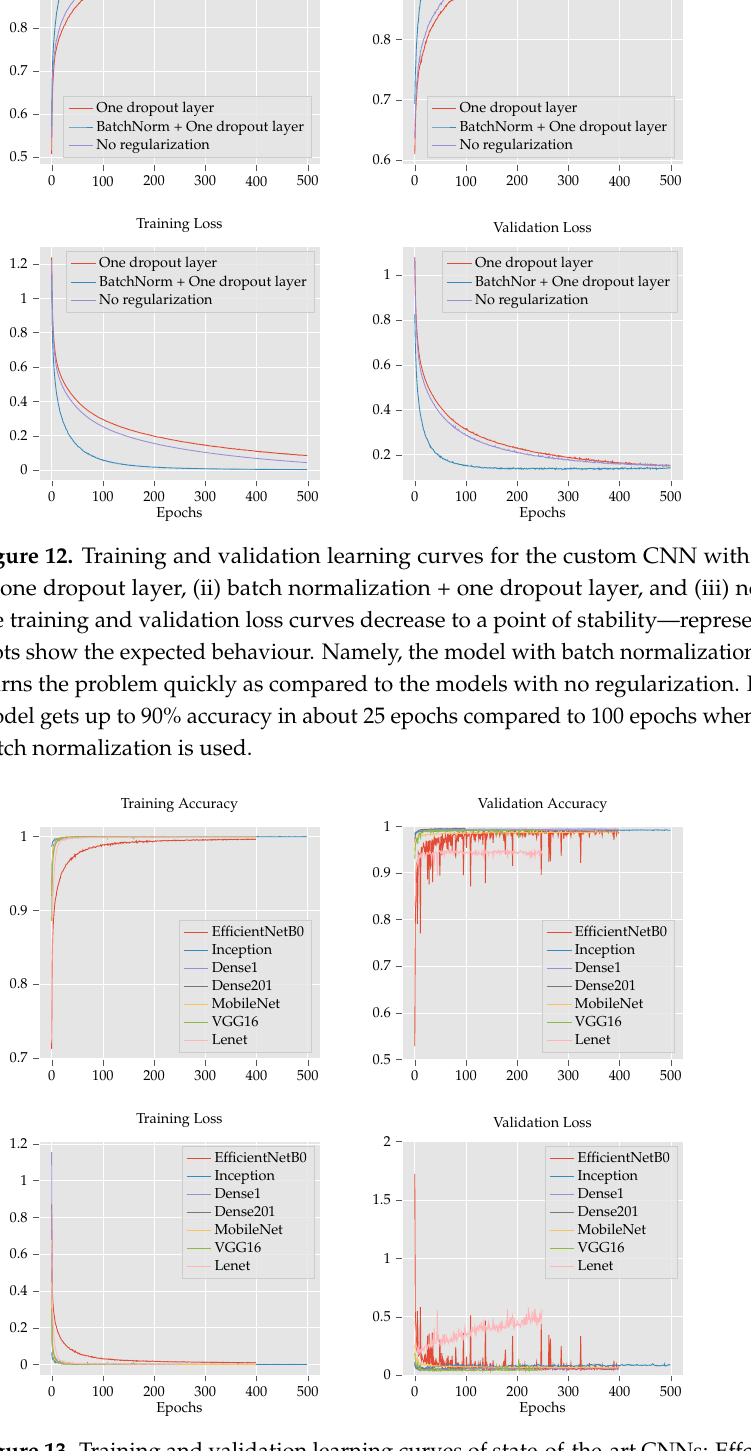
Figure 13. Training and validation learning curves of state-of-the-art CNNs: EffcientNetB0, Inception, DenseNet101, DenseNet201, MobileNet, VGG16 and Lenet. All the training and validation loss curves decrease to a point of stability—representing a good fit. All CNNs except EffcientNetB0 reach 99% accuracy in about 10